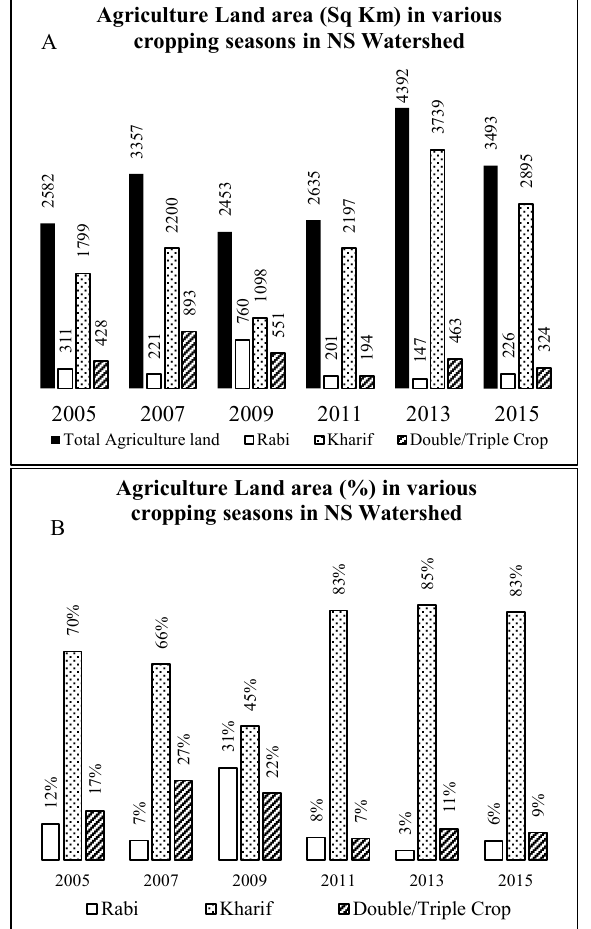
Figure 9: Shows the amount of active agricultural land in NS watershed in various cropping seasons. Figure 9A and 9B show the area under each cropping season as Km 2 and % respectively. Figure 11: Shows the increase in the Nitrogen, Phosphorus and Potassium usage in India from 1951 –